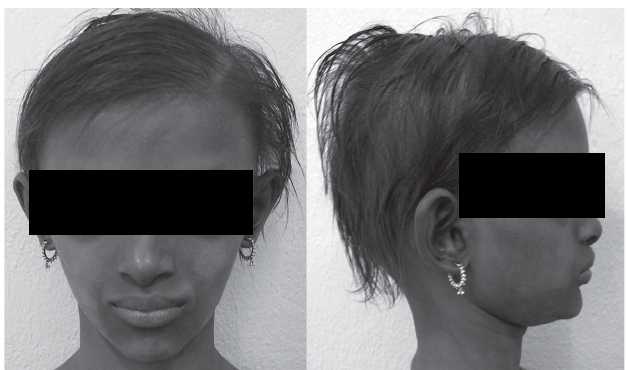
Fig. 7 : Frontal and lateral final extra oral views of the patient’s face at the 12-month follow-up